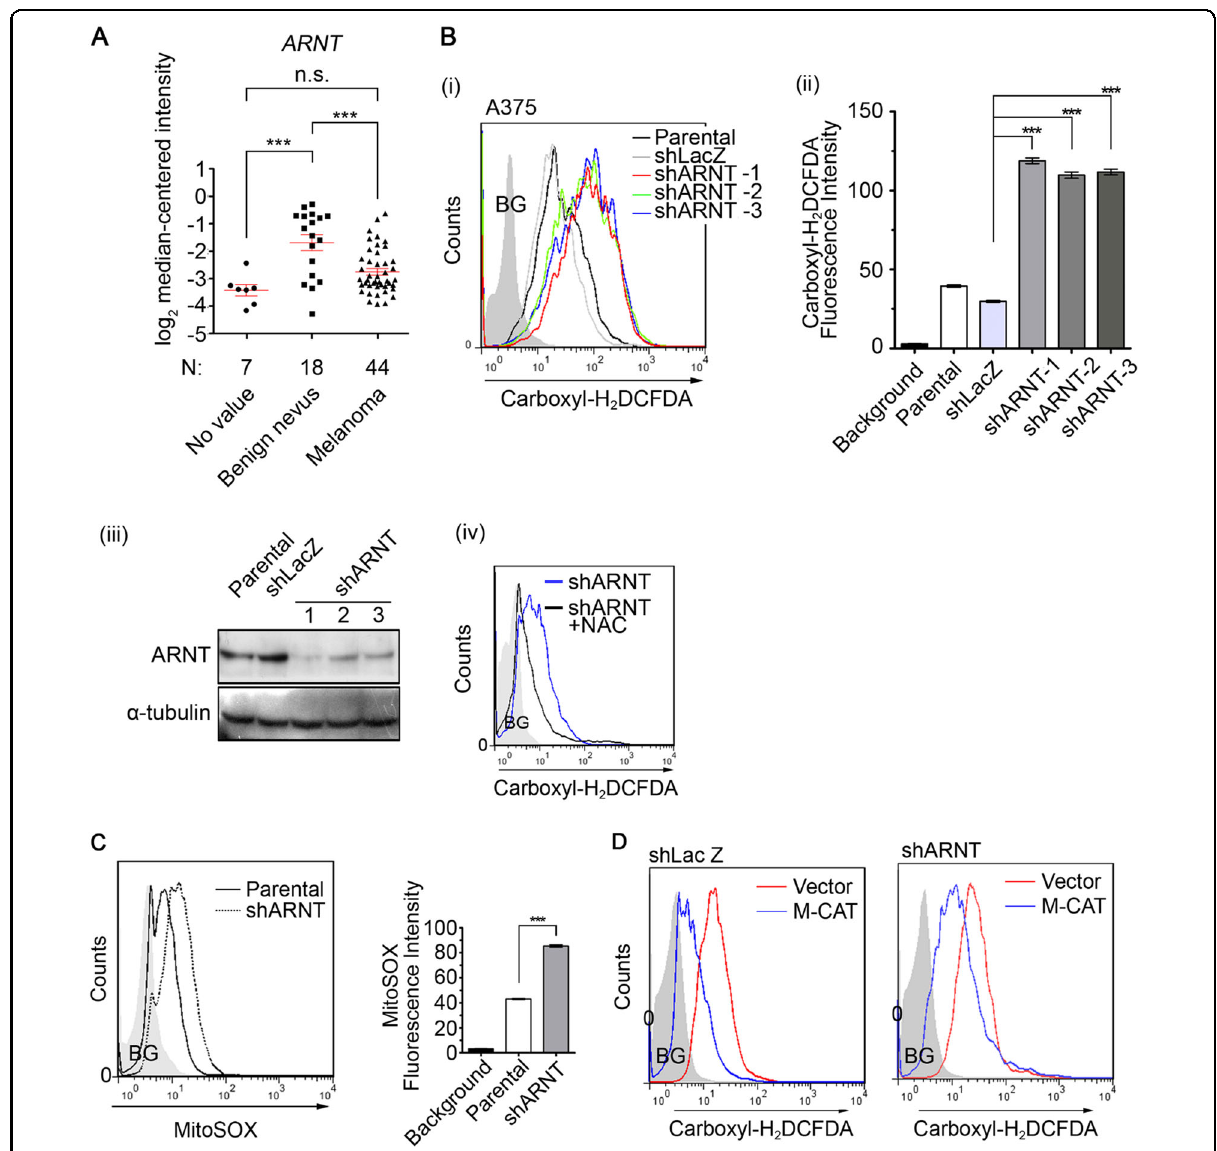
Fig. 1 The ARNT de fi ciency is observed in melanoma tissues and triggers increase of ROS levels. A ARNT expression was determined from different stages of human melanoma 56 Values are indicated as the mean ± s.e.m. P values were calculated with one-way ANOVA or t-test. Values are indicated as the mean ± s.e.m. *** P < 0.001; n.s.: no signi fi cant difference. B Carboxyl-H 2 DCFDA staining was performed to quantify the ROS levels in shRNA-mediated ARNT silencing in A375 cells (shARNT). After 30 min incubation, cells were recovered with fully medium. The carboxyl-H 2 DCFDA signal was detected by fl ow-cytometry (i). The fl uorescence intensity of carboxyl-H 2 DCFDA from individual cells was calculated using statistical analysis by Prism 6.0 software (ii). ARNT levels were examined using western blots (iii). Cells were treated with NAC (20 mM)-containing medium for 24 h. The ROS signal was analyzed by fl ow-cytometry (iv). C The mitochondrial superoxide levels were analyzed using MitoSOX Red staining in shARNT A375 cells. After 10 min incubation with 5 μ M MitoSOX Red, the signal was detected by fl ow-cytometry (left panel). The fl uorescence intensity of MitoSOX Red from individual cells was quanti fi ed using Prism 6.0 software (right panel). D Cells were transfected with